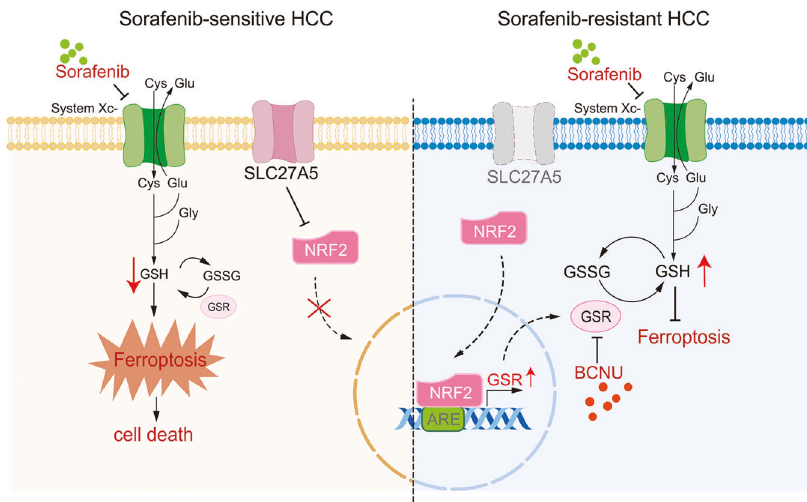
Fig. 8 Proposed mechanistic model of sorafenib resistance caused by SLC27A5 de fi ciency. In sorafenib-sensitive cells, NRF2 is not activated and the restricted Cys transport and low levels of GSH result in enhanced ROS and oxidative stress. Cells are more susceptible to ferroptosis elicited by sorafenib. By contrast, SLC27A5 de fi ciency in sorafenib-resistant HCC cells activates the NRF2/GSR pathway to keep glutathione homeostasis and thus promotes cell survival under sorafenib treatment. GSR inhibition-BCNU signi fi cantly reduced the enzyme activity of GSR. Low GSH levels contribute to enhancing sorafenib-induced ferroptosis in HCC. ARE antioxidant response